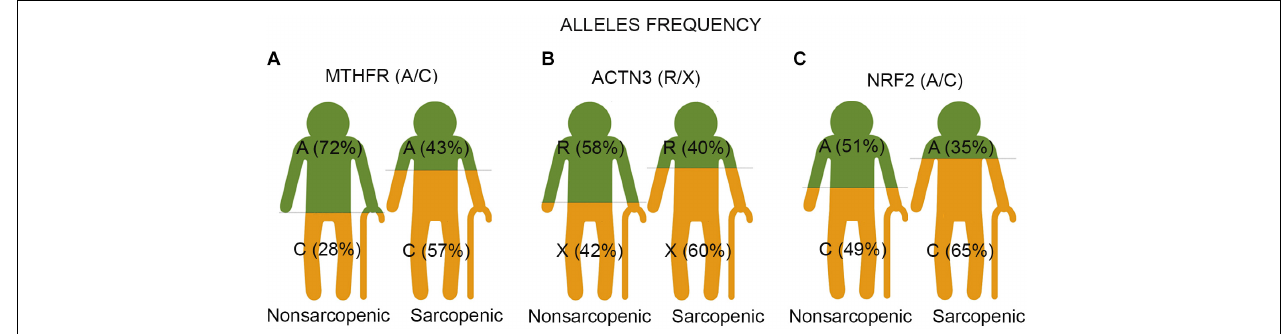
FIGURE 1 | The representative images show the result of three single nucleotide polymorphisms (SNPs) associated with sarcopenia in older adults. Each image represents two groups of participants – non-sarcopenic and sarcopenic. (A) The study identifies the C allele of polymorphic variants (rs1801131 A/C) of the MTHFR gene as a risk factor for sarcopenia in older adults. The Chi-square association test showed significantly higher frequencies of the C allele in sarcopenic participants than in controls (57% vs. 28%, p < 0.001). The C-allele carriers had 3.3 increased odds ratios for the likelihood of being sarcopenic compared to the A-allele carriers. (B) The X allele of ACTN3 R577X (rs1815739 R/X) was associated with sarcopenia risk in older adults. The Chi-square association test showed significantly higher frequencies of the X allele in sarcopenic participants than in controls (60.0 vs. 42%, p = 0.003). The X allele carriers had 2.0 increased odds ratios for the likelihood of being sarcopenic compared to R allele carriers. (C) The C allele of NRF2 (rs12594956 A/C) was identified as a risk factor for sarcopenia in older adults. The Chi-square association test demonstrated significantly higher frequencies of the C allele in sarcopenic participants than in controls (65 vs. 49%, p = 0.009). The C-allele carriers had 1.9 increased odds ratios for the likelihood of being sarcopenic compared to carriers of the A allele. TABLE 1 | Odds ratio (OR) and 95% confidence interval of MTHFR, ACTN3, and NRF2 genotypes for sarcopenia. Unadjusted models Adjusted models Dominant Recessive Dominant